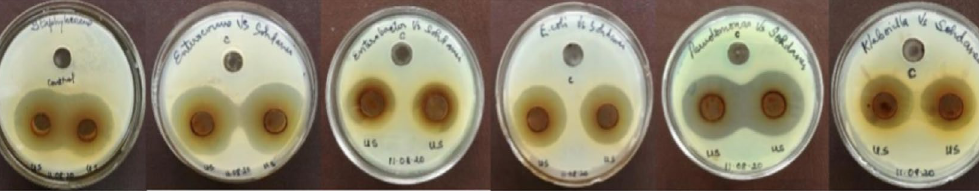
Fig. 4. Plates of Well diffusion assay showing antibacterial activity of G. pedunculata methanol extract on UTI clinical bacterial isolates.(C=control well filled with methanol; US=well filled with MEGP).